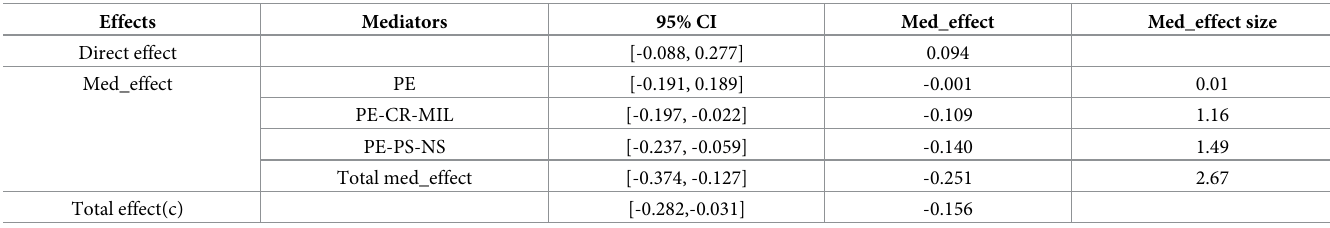
Table 3. Test results of the mediation effect of model